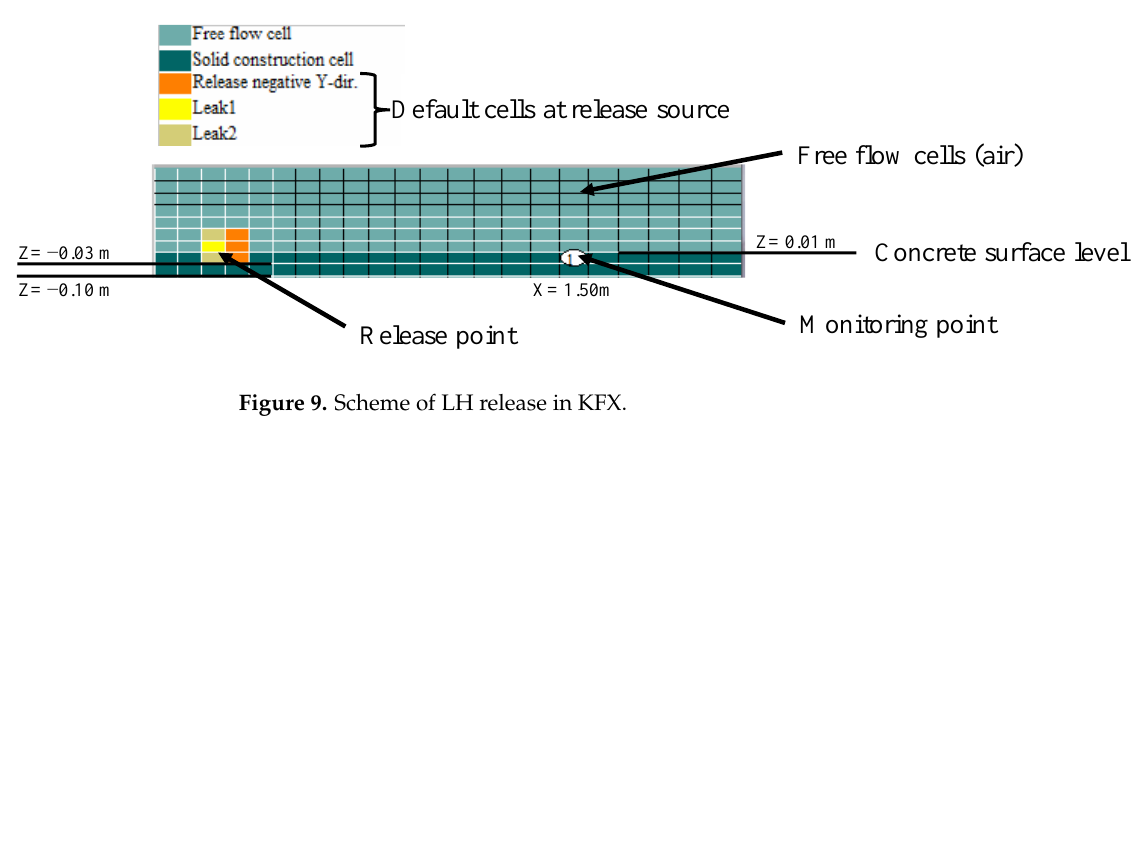
Figure 9. Scheme of LH release in KFX.